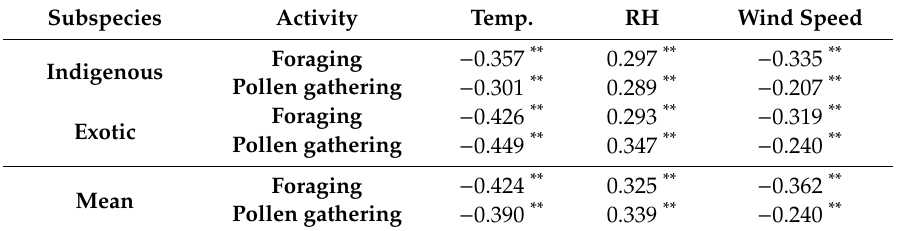
Table 1. Pearson correlation coe ffi cient factors between foraging and pollen-gathering rates